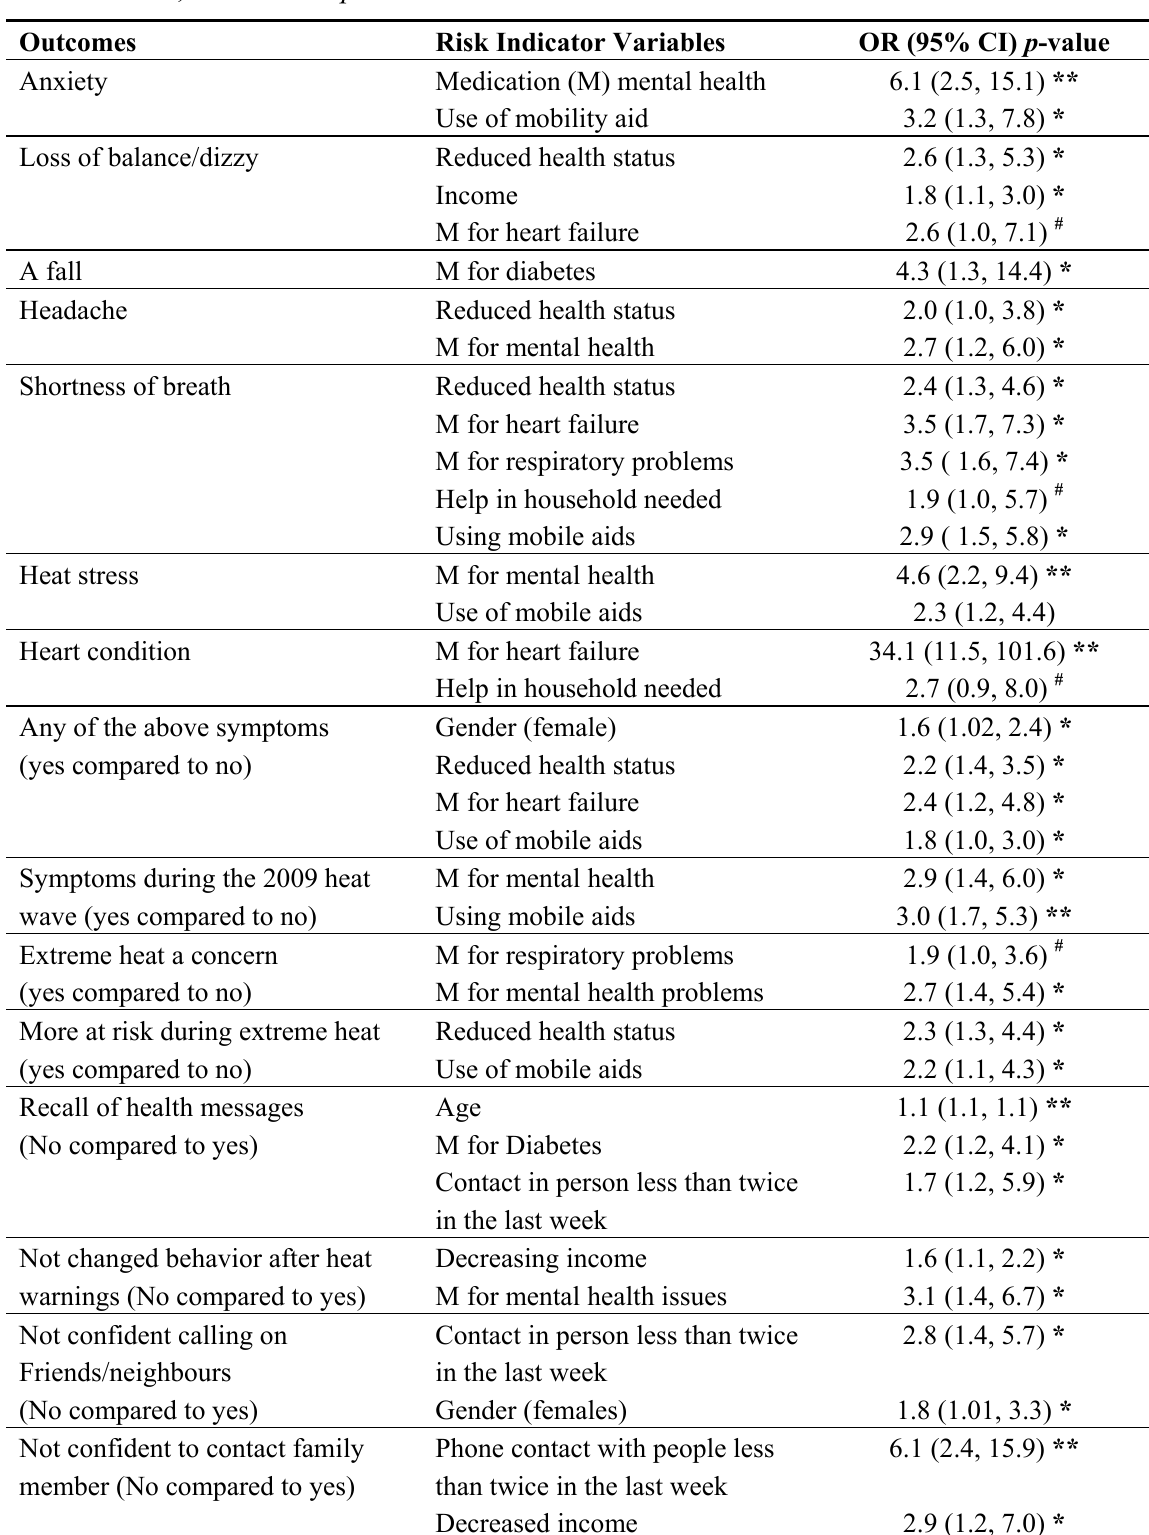
Table 5. Multivariate relationships between heat health outcomes and risk indicators. Odds Ratios, 95% CI and p